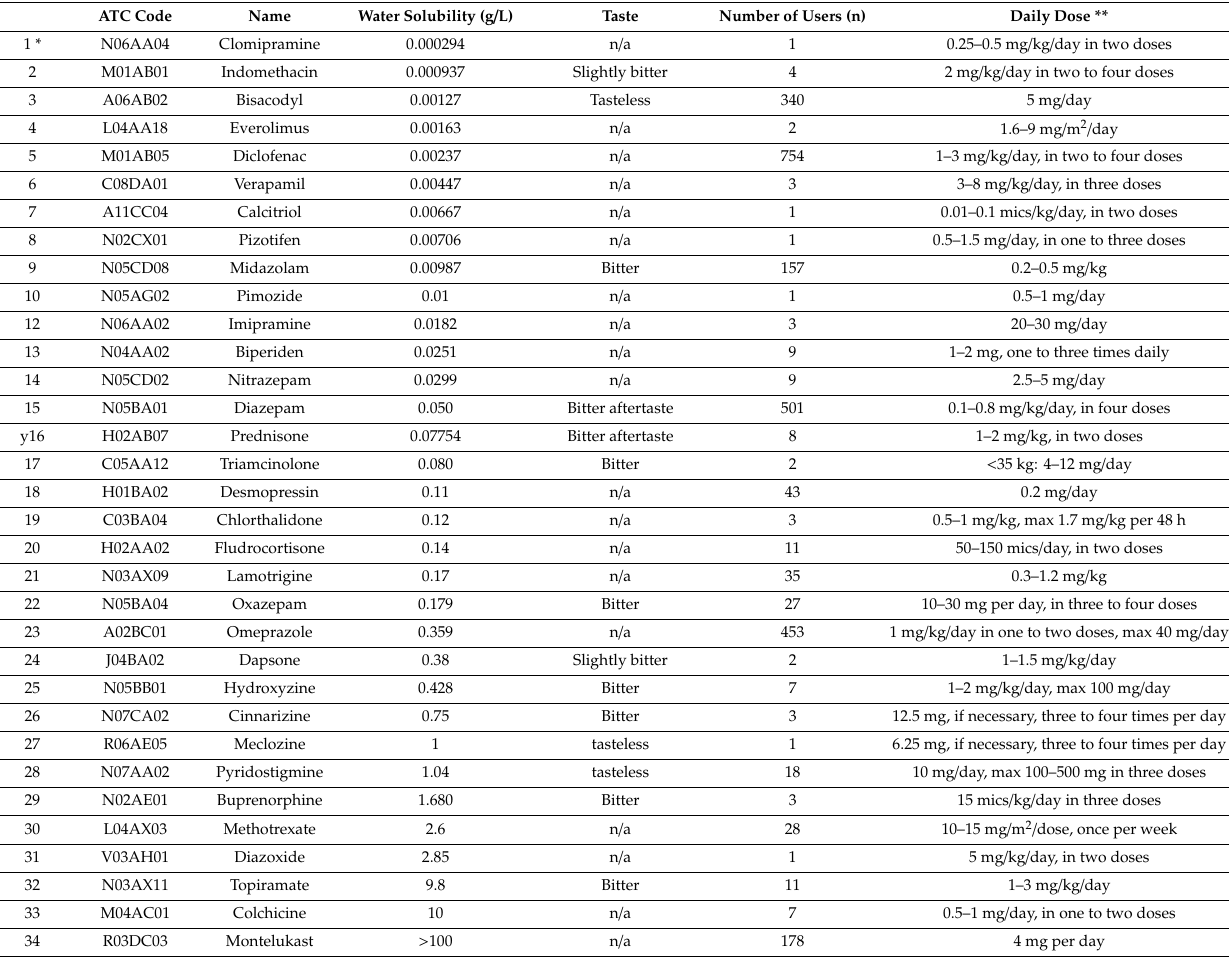
Table 3. Candidates for ODF formulation development via inkjet printing, arranged by water-solubility. ATC